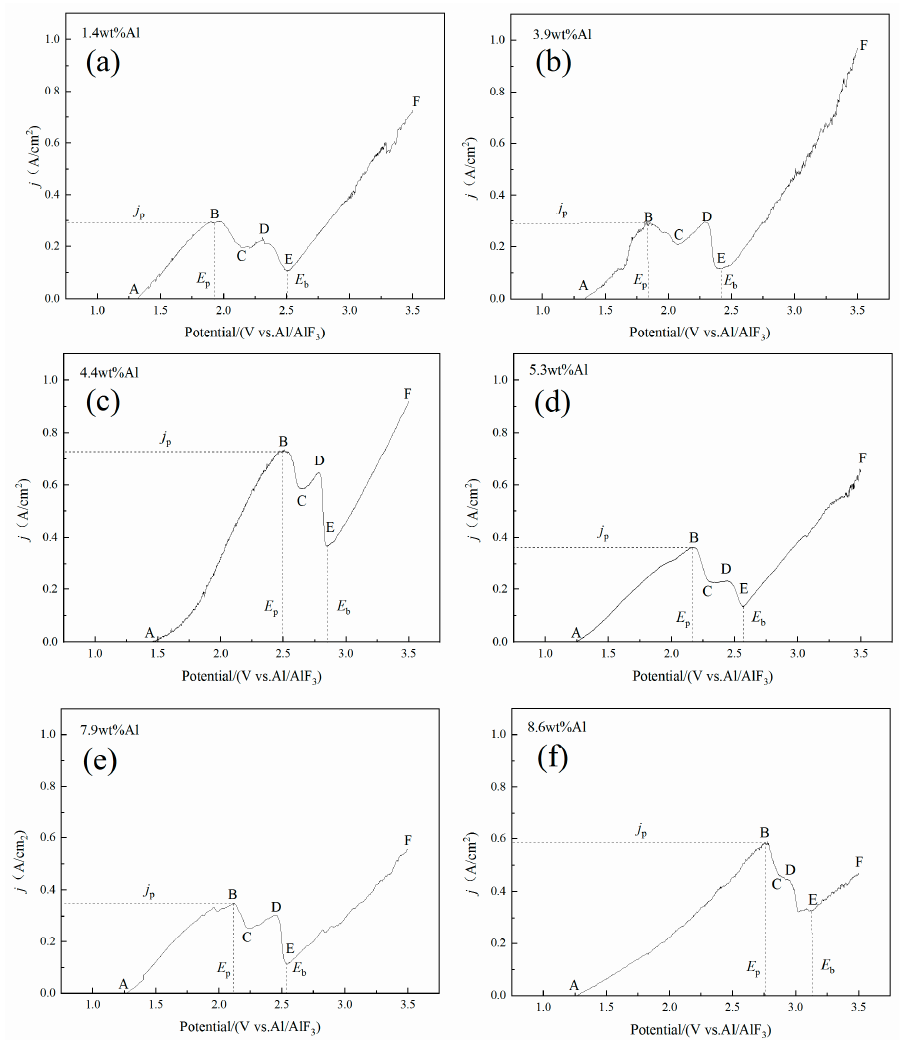
values are shown in Table 4. E corr is a thermodynamic parameter while I corr is a kinetic parameter.